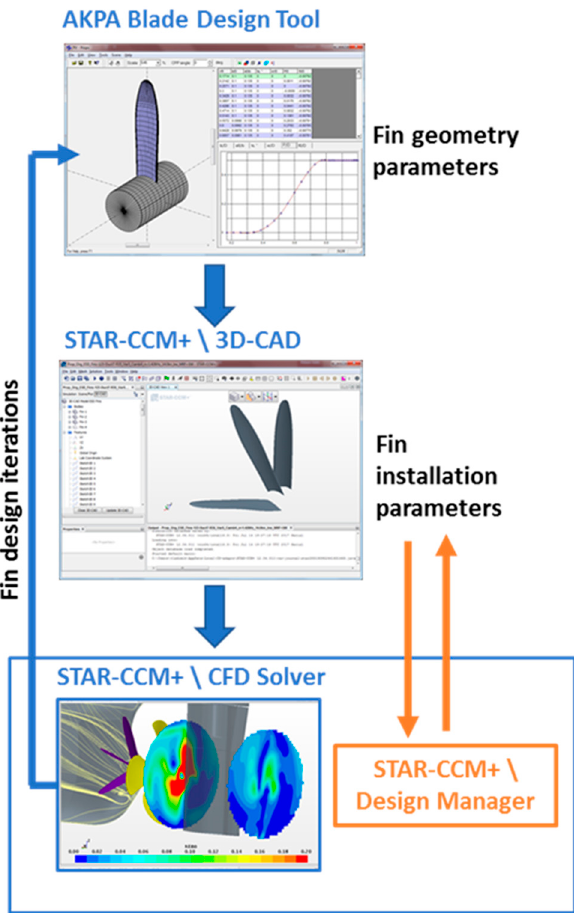
Figure 6. Overall flow chart of the ESD design workflow.